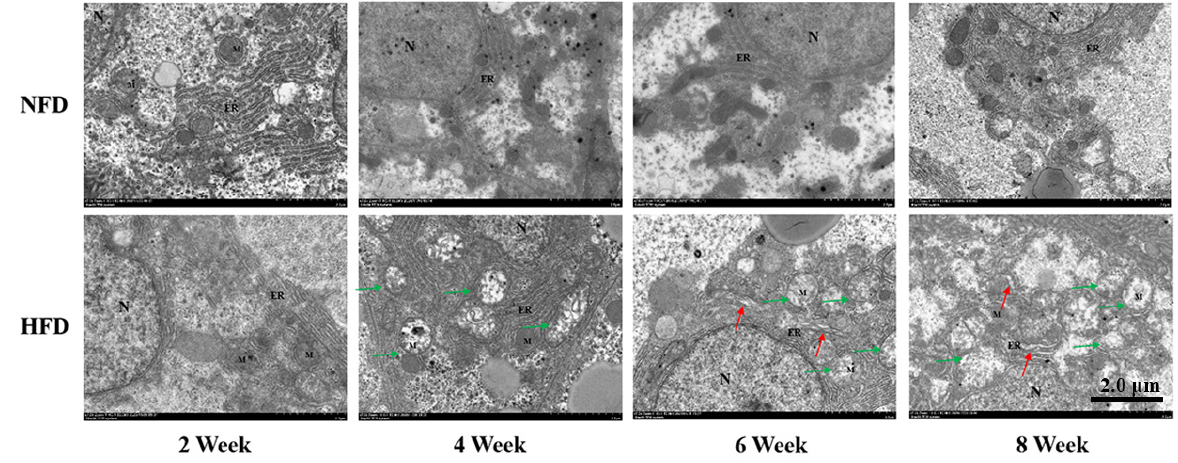
6 of 12 Figure 3. Experiment I. The expressions of fat metabolism-related genes in the liver. ( A ) Gene ex- pression of fas . ( B ) Gene expression of srebp-1c . “*” indicates a significant difference between groups ( p < 0.05, Student’s t -test, n = 3). 3.1.2. Ultrastructure of Hepatocytes